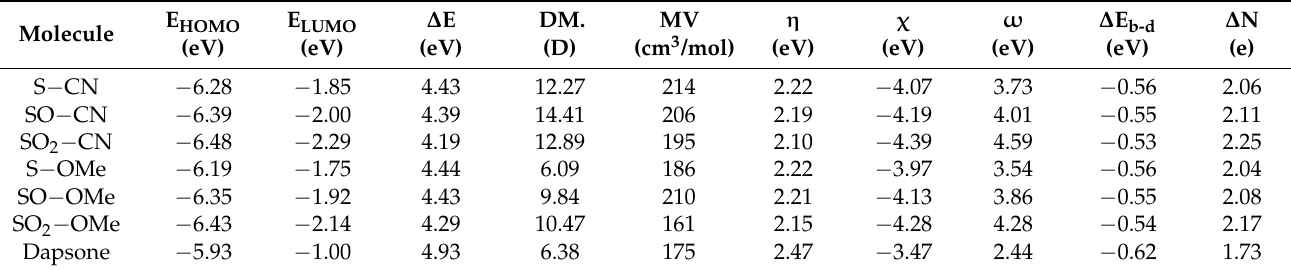
Table 3. The DFT global reactivity descriptors of the studied